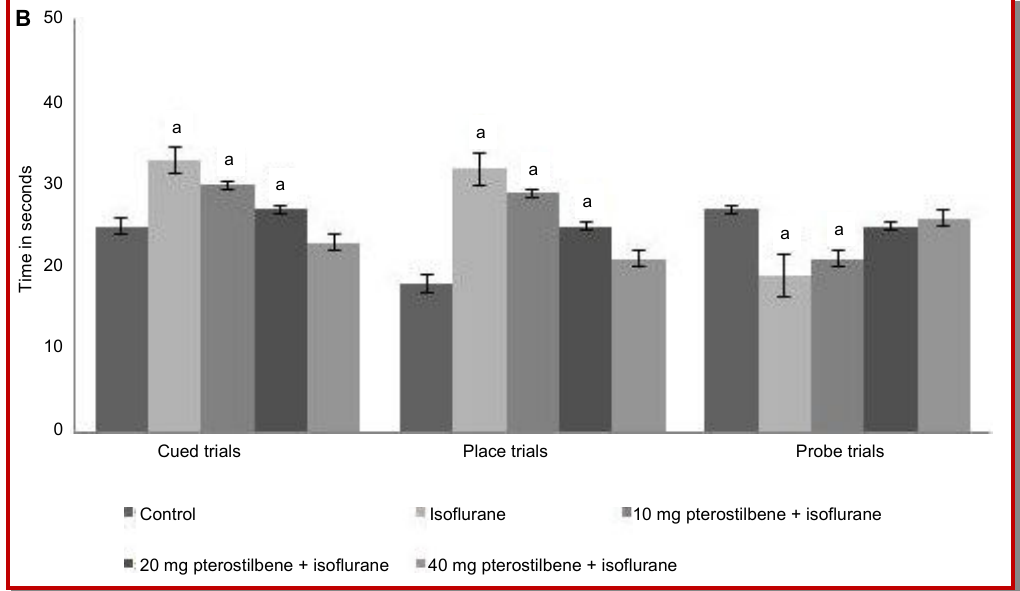
Figure 3B: Learning and memory of the rat pups determined by cued, place and probe trials with the Morris water maze Values are represented as mean ± SD, n=6. a represents statistical significance at p<0.05 compared against control as determined by one-way